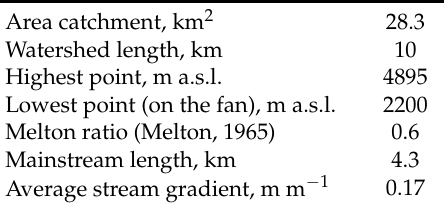
Table 1. Main morphometric parameters of the Aksay